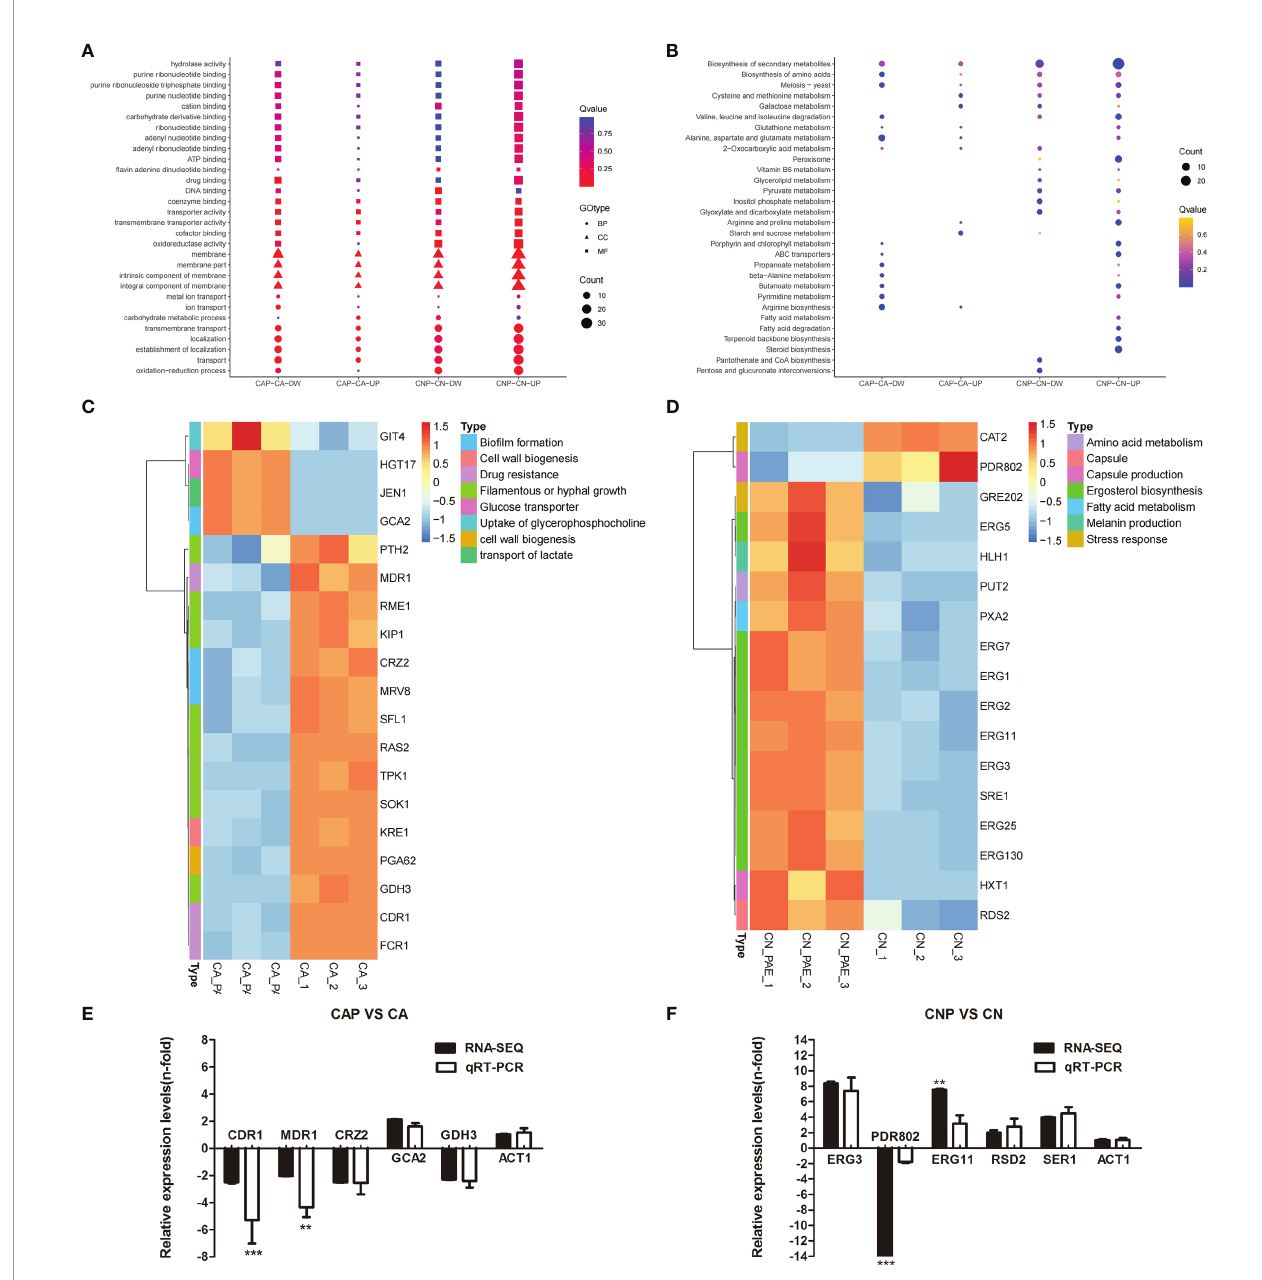
FIGURE 10 | Transcriptomic analysis of paeonol-treated C. albicans SC5314 and C. neoformans H99 bio fi lms. (A, B) The Gene Ontology (A) and Kyoto Encyclopedia of Genes and Genomes (B) pathway enrichment analysis of differentially expressed genes (DEGs) in paeonol-treated C. albicans SC5314 (CAP) and C. neoformans H99 (CNP) bio fi lms as compared with the untreated control were depicted. After C. albicans SC5314 and C. neoformans H99 bio fi lms were exposed to paeonol at 1/2 MIC, respectively, their transcriptomic pro fi les were examined. The sphere size was proportional to the number of DEGs. (C, D) Heat maps of the DEGs related to C. albicans SC5314 (C) and C. neoformans H99 (D) bio fi lm formation or virulence factors were constructed using ImageGP, where absolute n ‐ fold changes of DEGs in three biological replicates in each condition, and their corresponding biological function on the right side of each panel were depicted. (E, F) The expression of selected DEGs and ACT1 (control) during C. albicans SC5314 (E) and C. neoformans H99 (F) bio fi lm formation in the presence of paeonol relative to their expression under the untreated condition was quanti fi ed by quantitative reverse transcription polymerase chain reaction (qRT-PCR, light grey bars) to compare RNA-sequencing data (RNA- SEQ, black bars). Bars represent the average relative change in RNA abundance of the indicated genes, and error bars indicate standard deviations ( n = 3 in each condition). Asterisks depict signi fi cantly different gene expression levels as compared between RT-PCR and RNA-sequencing data using a standard Student ’ s t -test (** p < 0.01; *** p <